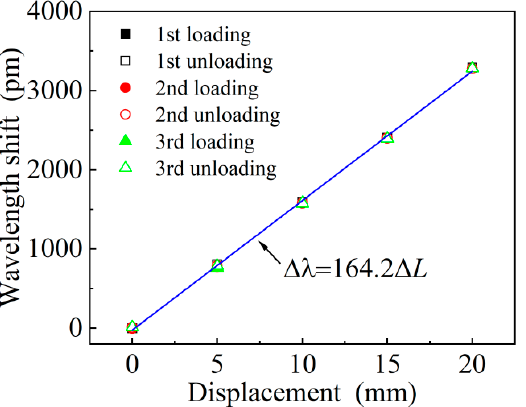
Figure 6. Wavelength shift versus displacement during three periods of displacement cycle test.